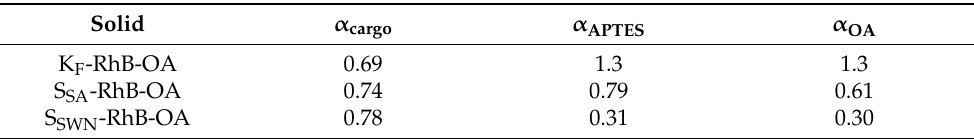
Table 3. Content ( α ) in mmol g − 1 residue (after calcination) of cargo, APTES and OA in the final organonanoclays, determined by TGA.